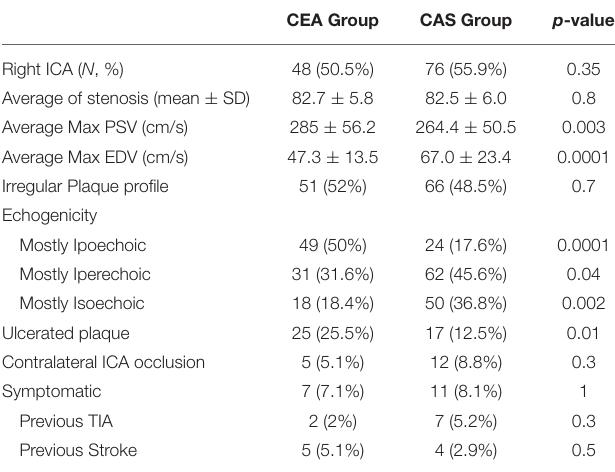
TABLE 2 | Carotid plaque features and neurological history. TABLE 3 | Procedural, technical